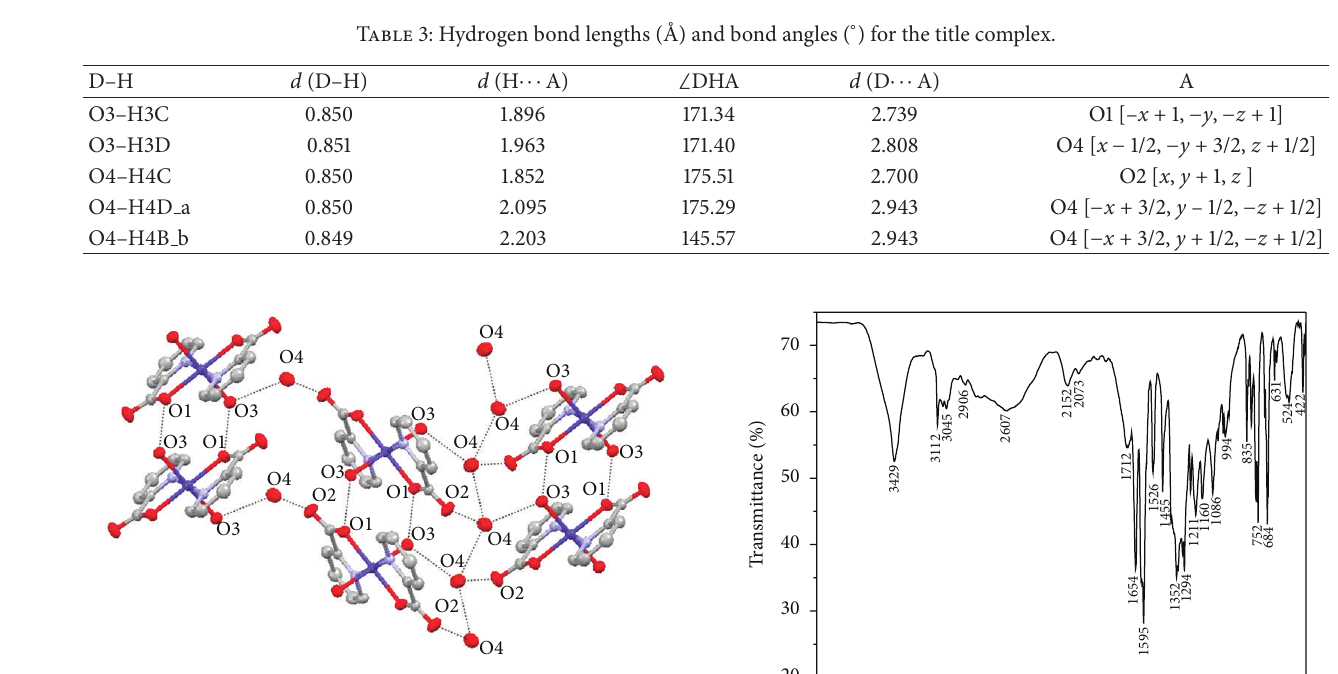
Figure 4: Packing diagram of the title complex showing H bonding.